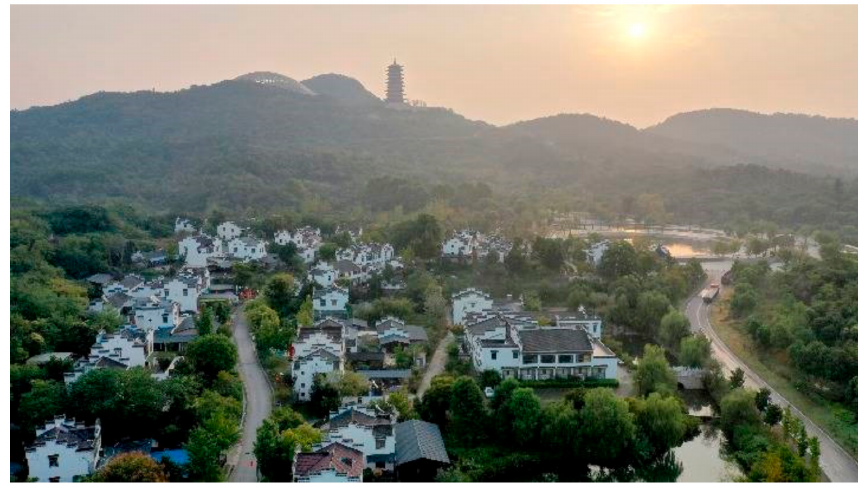
Figure 9. A rural tourist town with balanced social resources: Guli Street,